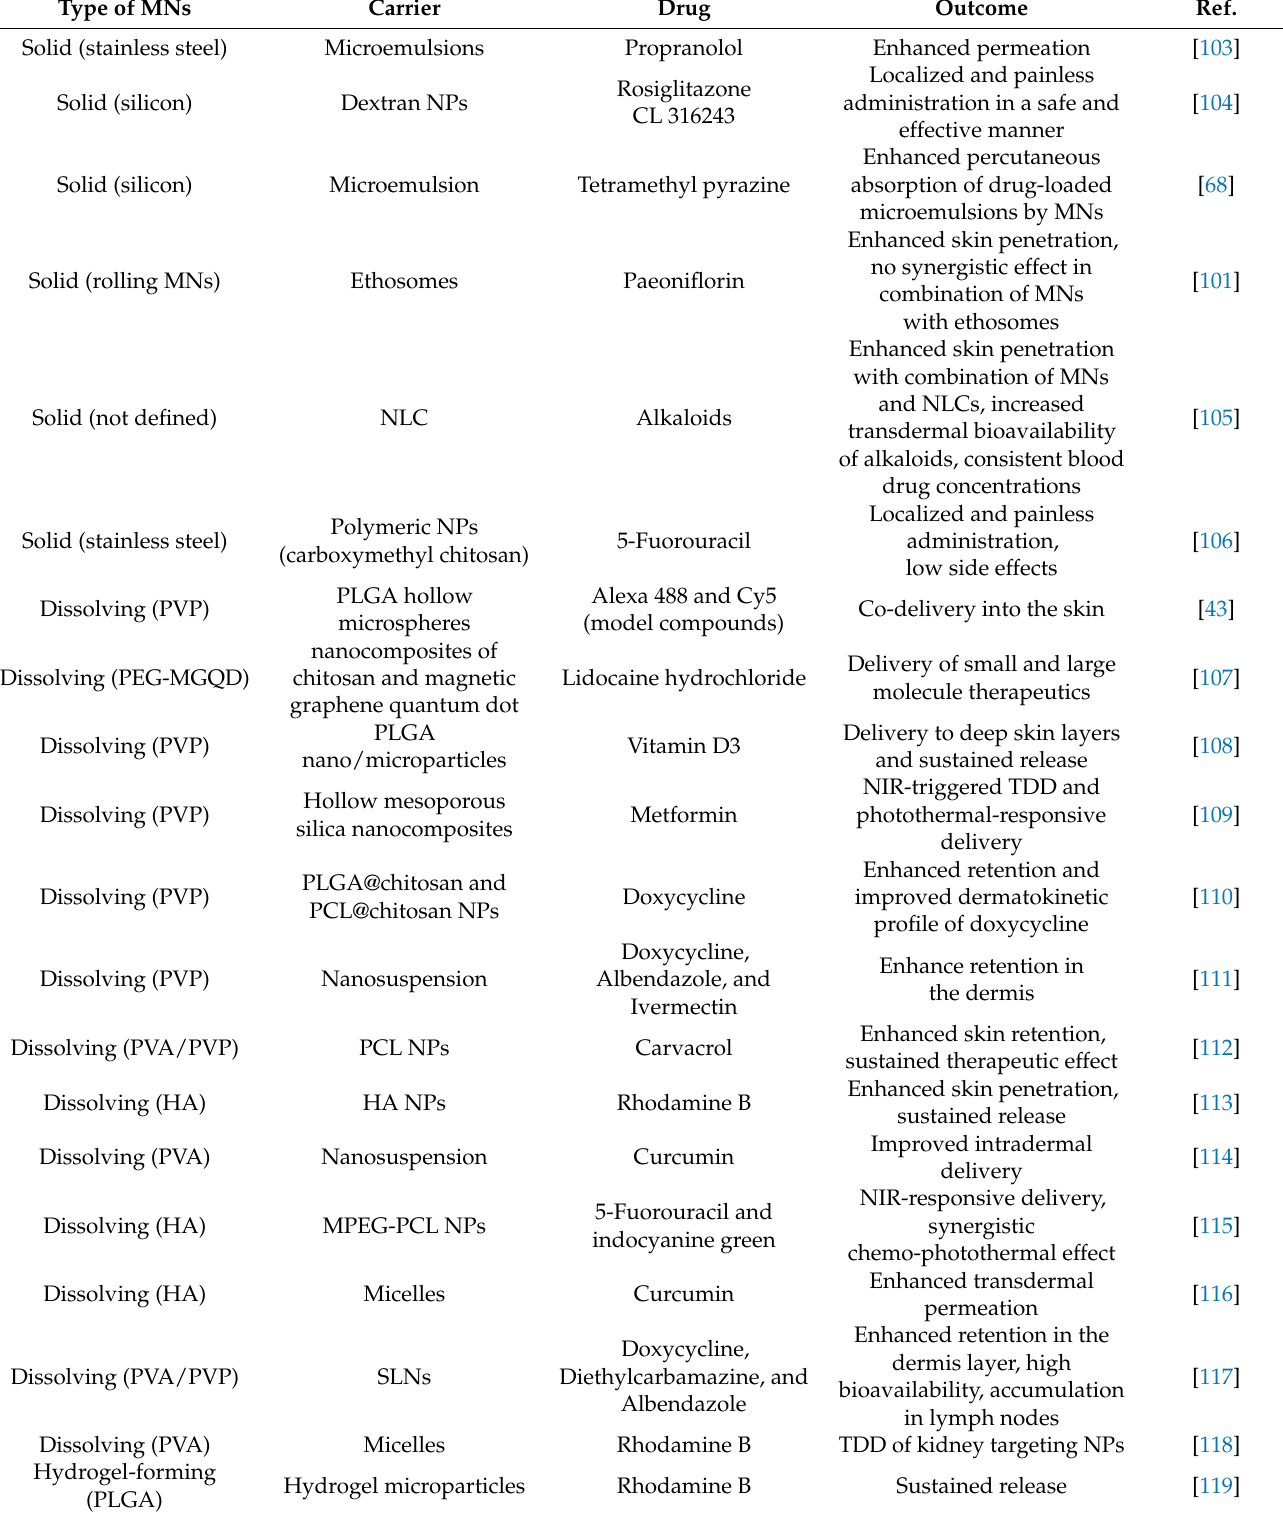
Table 2. Microneedle-assisted transdermal delivery of nanoparticles